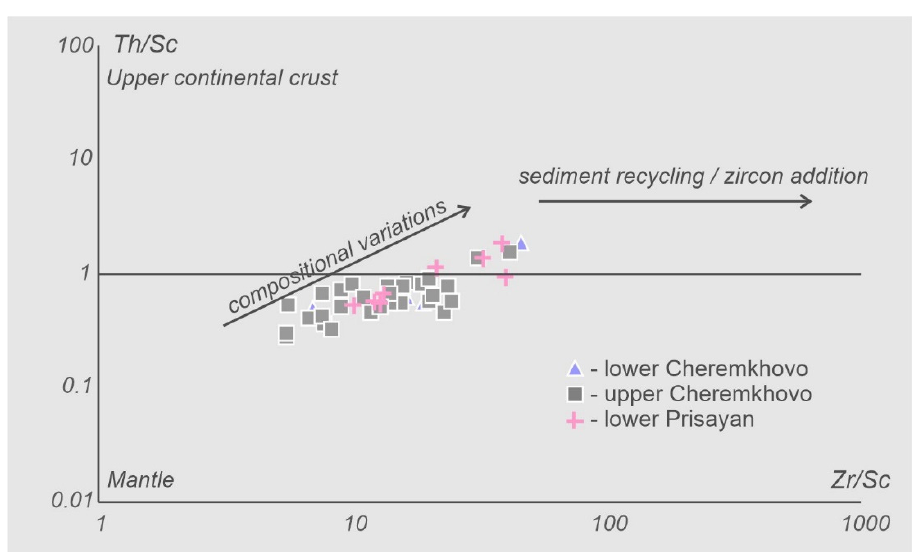
Figure 12. The Zr/Sc versus Th/Sc plot (after [39] ).